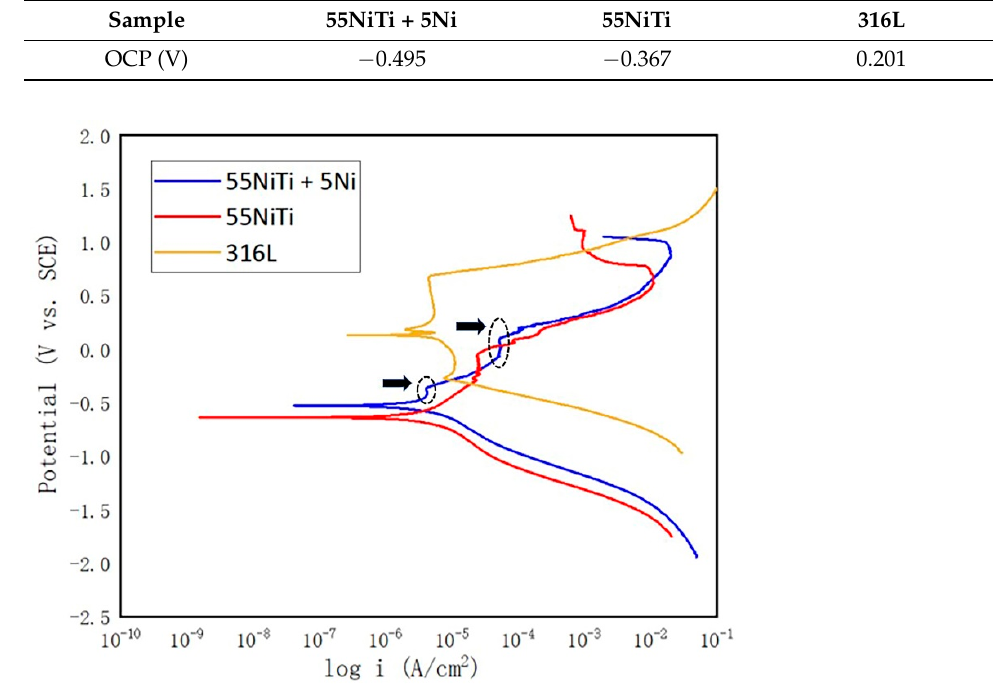
Figure 11. Potentiodynamic polarization behavior of the coatings and substrate. Table 5. Tafel fitting results of corrosion potential, corrosion current density and corrosion rate.